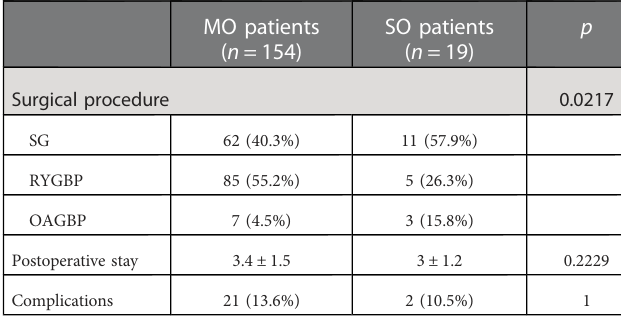
TABLE 2 Surgical management and postoperative complications.